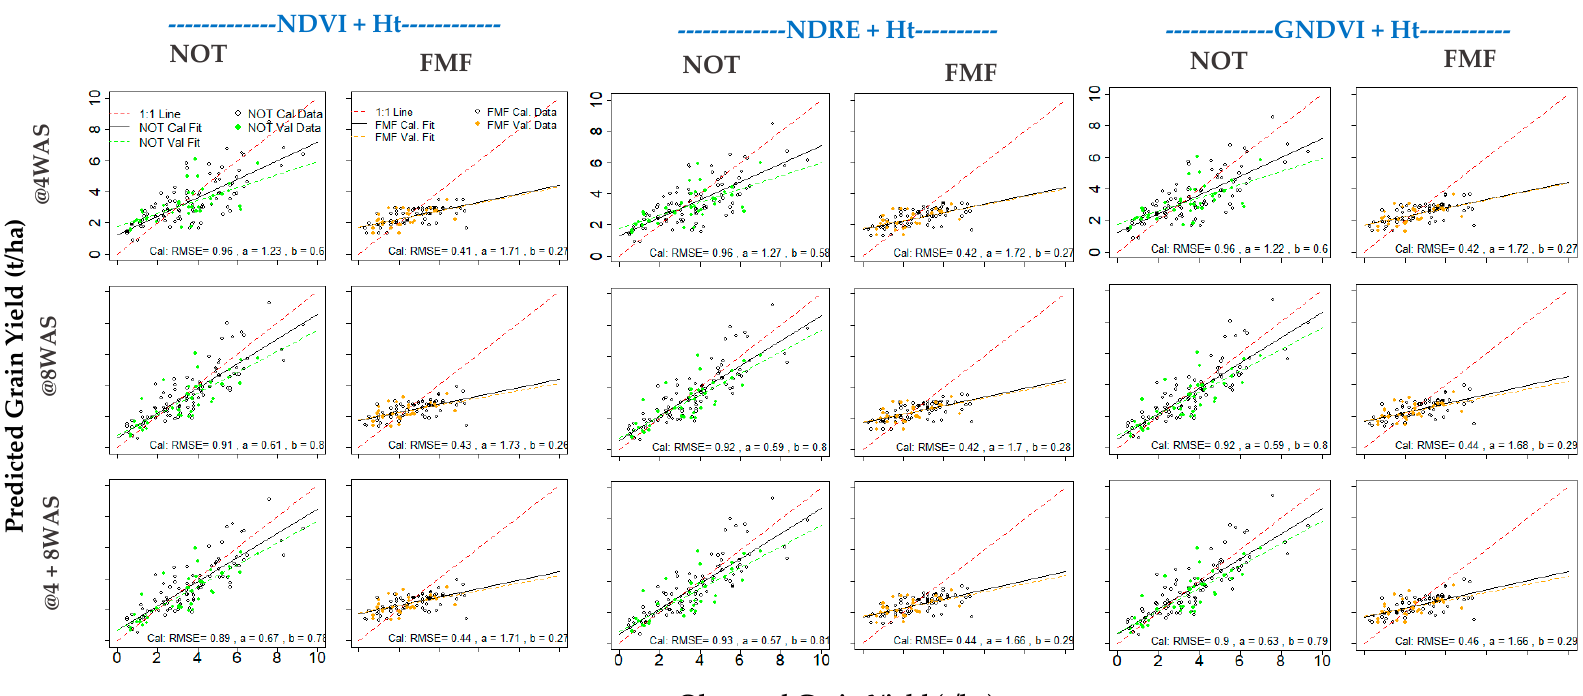
Figure 7. Relationship between observed and predicted maize grain yield based on fitted linear mixed effect model using and UAV-derived Vegetation Indices (VIs) combined with plant height (Ht) data from multilocation smallholder maize farms in Nigeria. NOT = Nutrient omission trials; FMF = Farmer managed fields; WAS = Weeks after sowing; a = Intercept; b = Slope estimate; Calibration (Cal) metrics are shown on the charts and additional Validation (Val) metrics are presented in Table 3a,b.